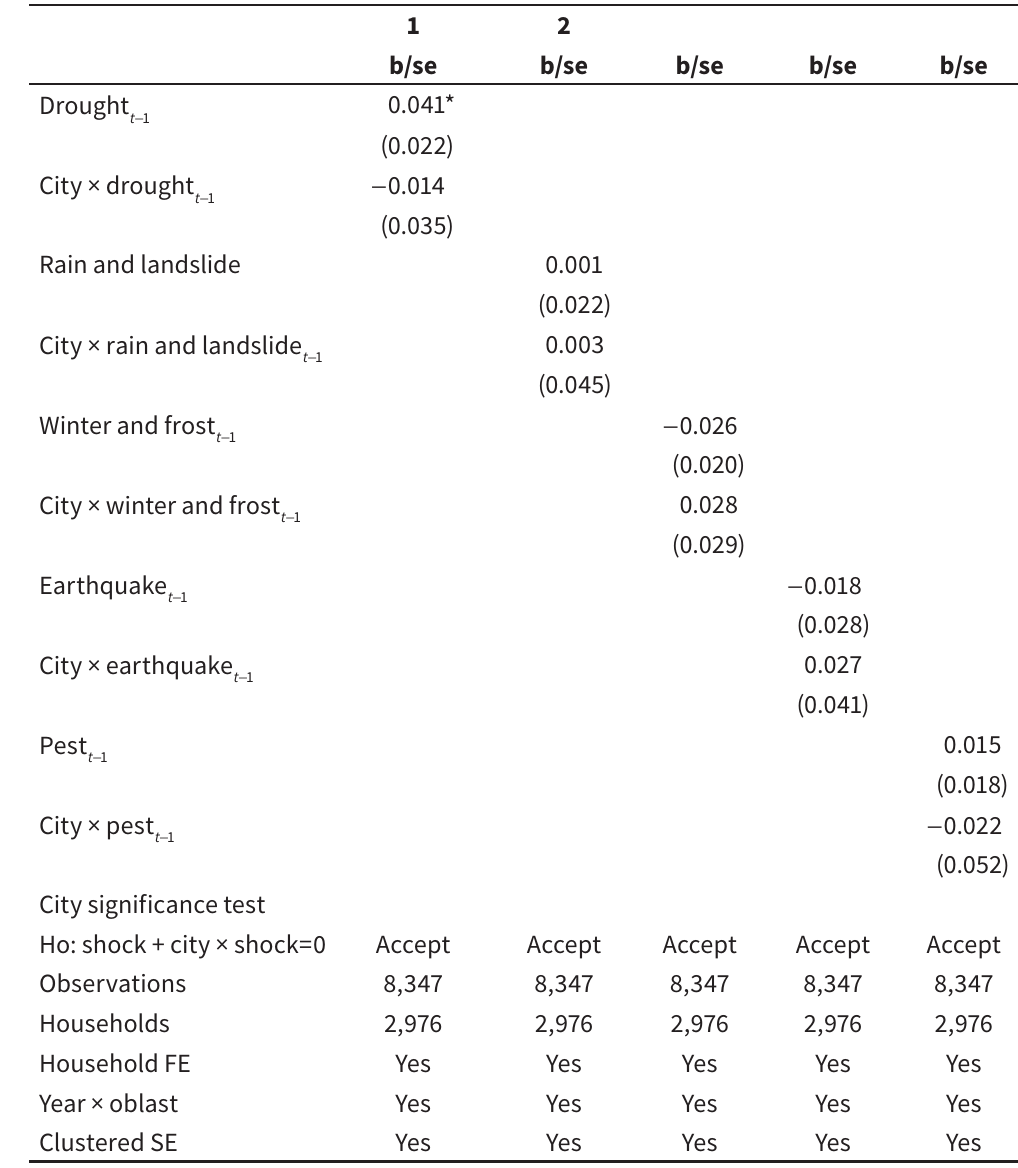
Migration and shocks: village versus city 1 2 b/se b/se b/se b/se b/se Drought t - 1